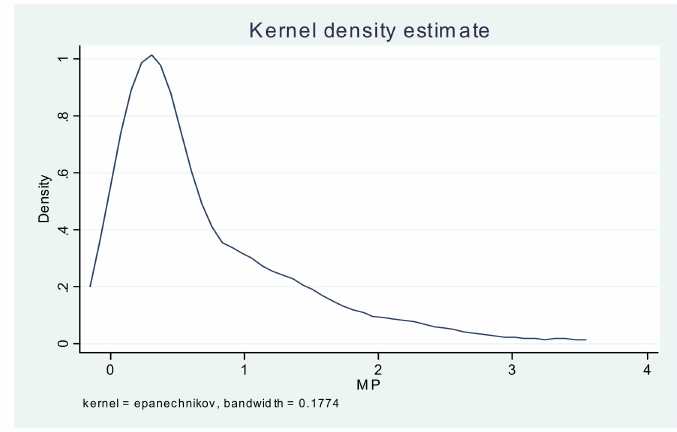
Figure 3. Kernel density distribution of the marginal productivity of the CF.